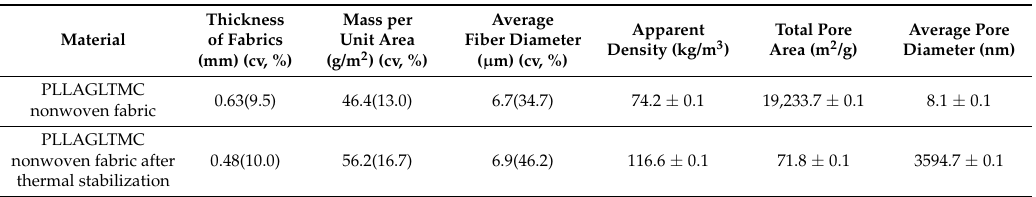
Table 2. Physical characteristics of the manufactured poly(lactide- co -glycolide- co -trimethylene carbonate) (PLLAGLTMC) nonwoven fabric before and after thermal stabilization.